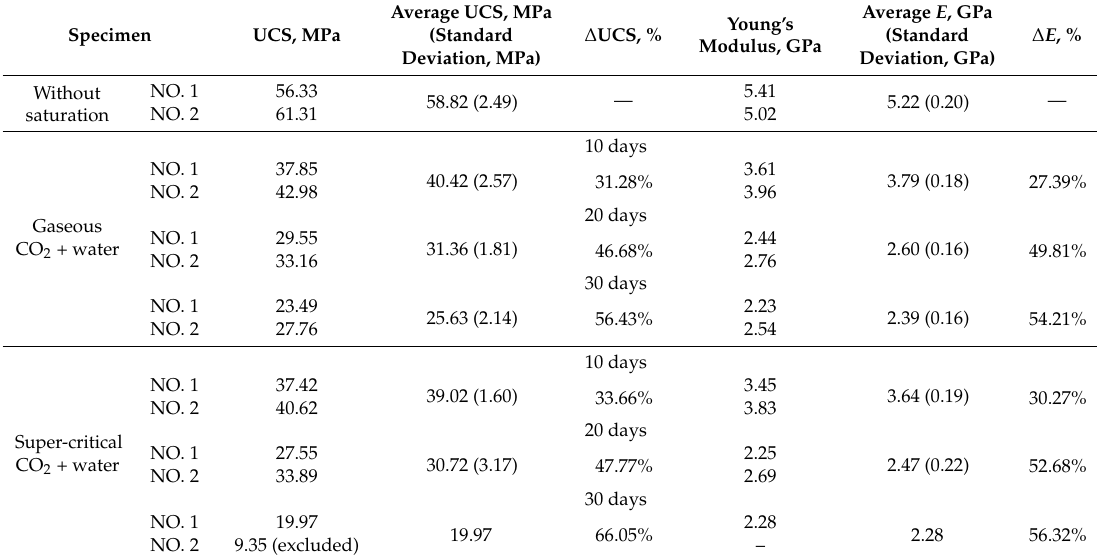
Table 3. Values of uniaxial compressive strength (UCS) and Young’s modulus (E) for all tested